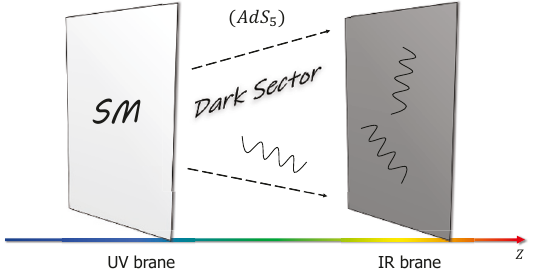
Figure 1 . Illustration of gravity-mediated dark matter in warp extra dimension. The SM Higgs boson, electroweak gauge bosons and leptons may live on the UV-brane, while the dark matter, the quarks and gluon may live on the IR-brane